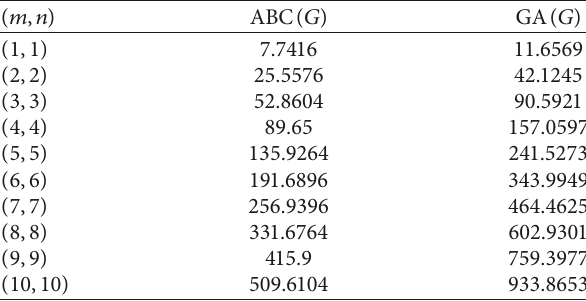
Table 3: Connection between ABC and GA.